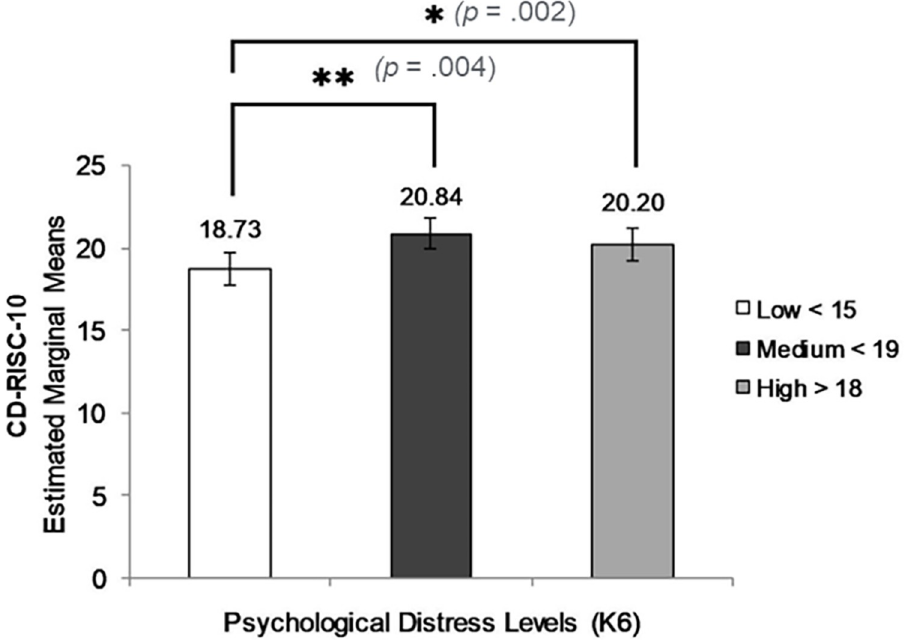
Fig 2. ANOVA results: CD-RISC-10 scores by level of psychological distress